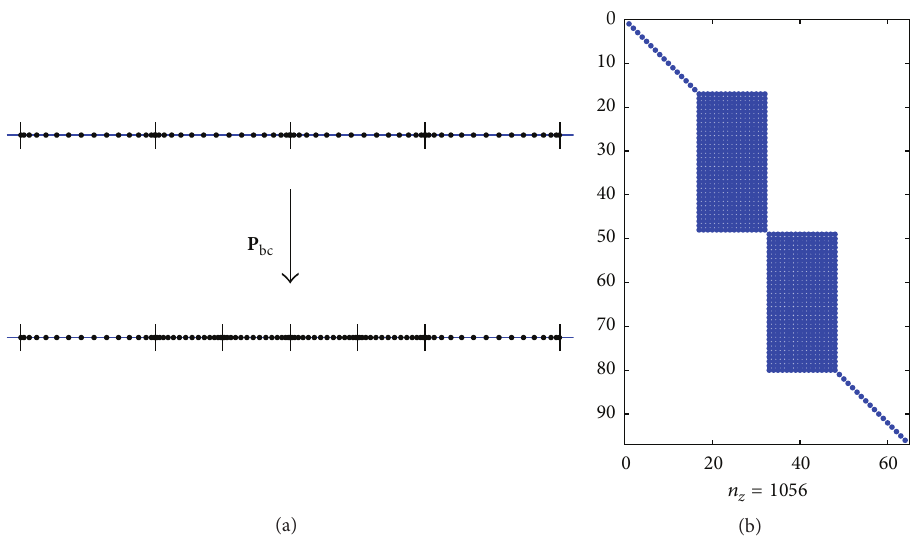
Figure 4: (a) The prolongation operator P performs panelwise interpolation from a grid on a four-panel mesh to a grid on a six-panel mesh. bc (b) The sparsity pattern of P bc